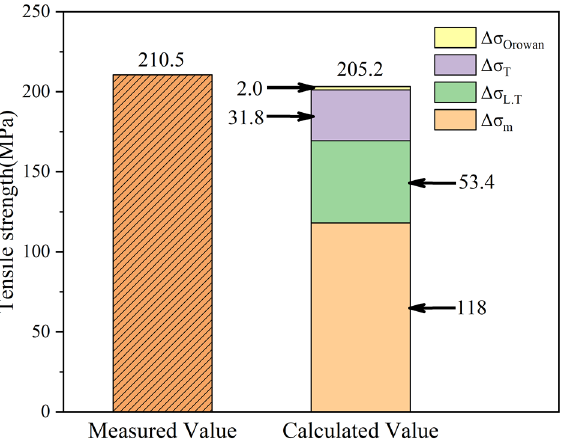
Figure 8. Calculated and measured values of tensile strength of PUCNTs/Zn composites.